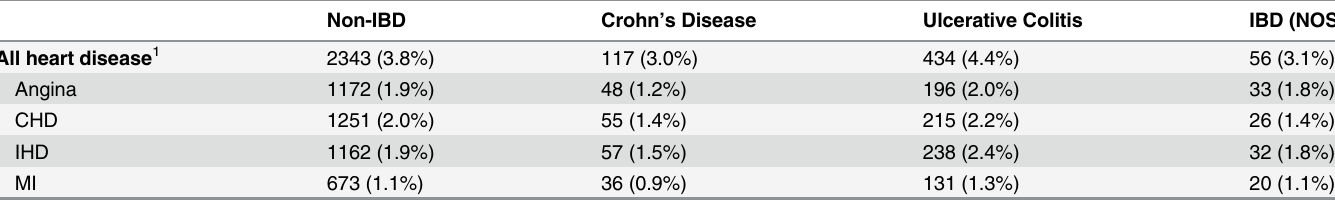
Table 4. Incidence of IHD among cases and controls (COHORT B) *